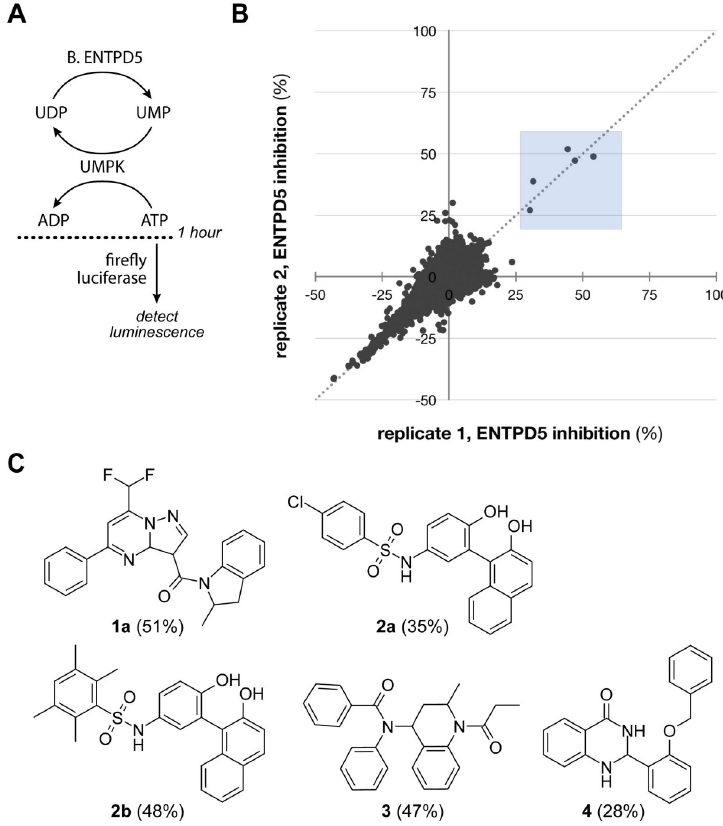
Fig 3. ENTPD5 HTS assay and screening results. A ) Schematic of ENTPD5 HTS assay. Following a 1-hour coupled reaction of ENTPD5 and UMPK, the residual ATP is measured indirectly using luciferase. B ) Replicate plot of ENTPD5 HTS, showing percent ENTPD5 inhibition by compounds in each replicate set. Compounds were screened at 20 μ M in duplicate. Compounds producing > 25% inhibition (blue shaded box in B ) were selected for follow-up analysis and are shown in C ). Percent ENTPD5 inhibition by each hit is shown in